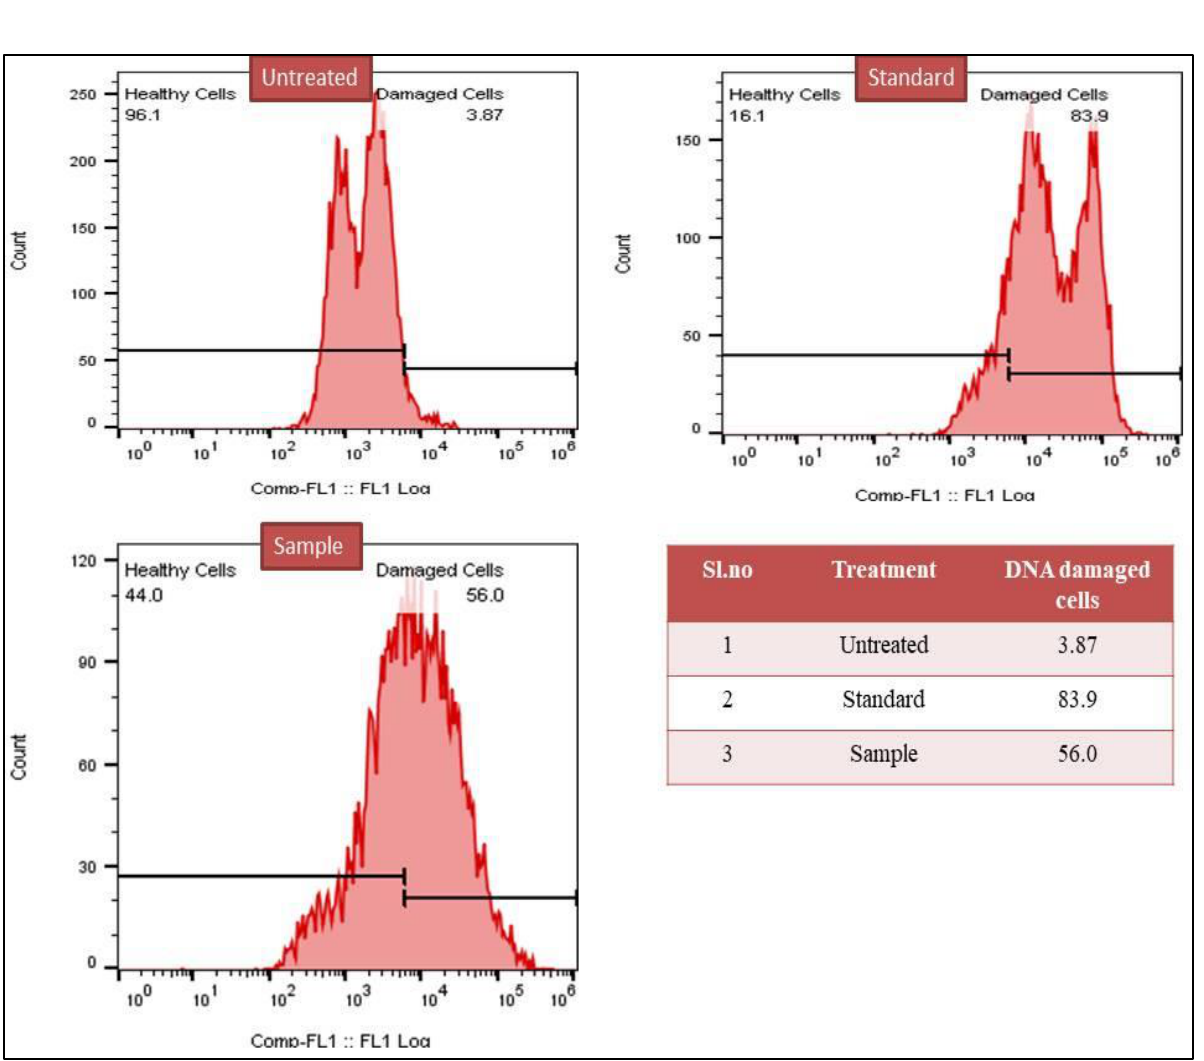
Figure 7. Flow cytometry-based study of DNA damage induced by methanol extract of C. colocynthis in the lung cancer A549 cell line.